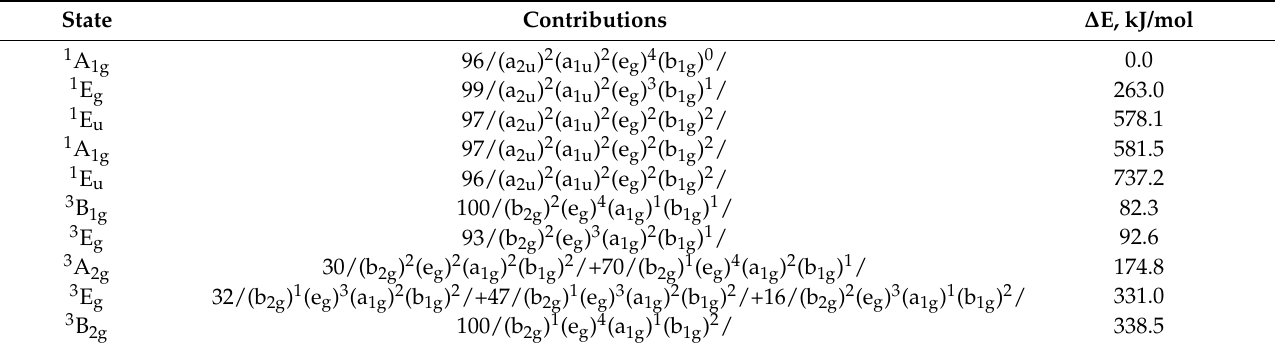
Table 2. The relative energies (kJ/mol) of exited states and contributions (in %) of electronic configurations to the wave functions from MCQDPT2 calculations.